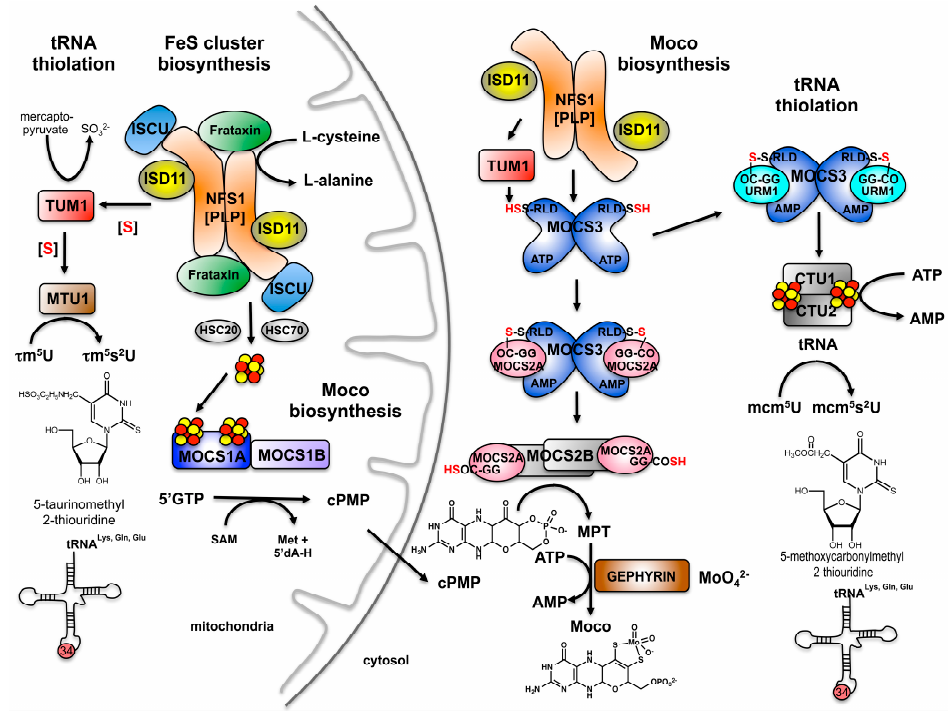
Figure 4. Localization of Moco biosynthesis, FeS cluster biosynthesis and tRNA thiolation in humans. Shown is a scheme of the biosynthetic pathway for Moco biosynthesis, FeS cluster biosynthesis and tRNA thiolation in humans. For Moco biosynthesis, the conversion of 5 ′ GTP to cPMP catalyzed by MOCS1A and MOCS1B, is localized in the mitochondria. This is also the main compartment for FeS cluster biosynthesis in eukaryotes. Synthesized cPMP is further transferred to the cytosol, where all further modification steps are catalyzed. These steps involve the conversion of cPMP to MPT by MOCS2A/MOCS2B and the sulfur transfer by MOCS3, the insertion of molybdate by gephyrin. The main compartment for FeS cluster biosynthesis is the mitochondrion, where NFS1 forms a complex with ISD11, ISCU and Frataxin. Formed FeS clusters are inserted into acceptor proteins such as MOCS1A. In mitochondria, NFS1 also transfers the sulfur to TUM1, a protein involved in the τ m 5 s 2 U formation of mitochondrial tRNAs. For TUM1, a dual localization has been revealed. For cytosolic tRNA modification, MOCS3 transfers the sulfur to URM1, which is involved in the formation of mcm 5 s 2 U modified nucleosides in